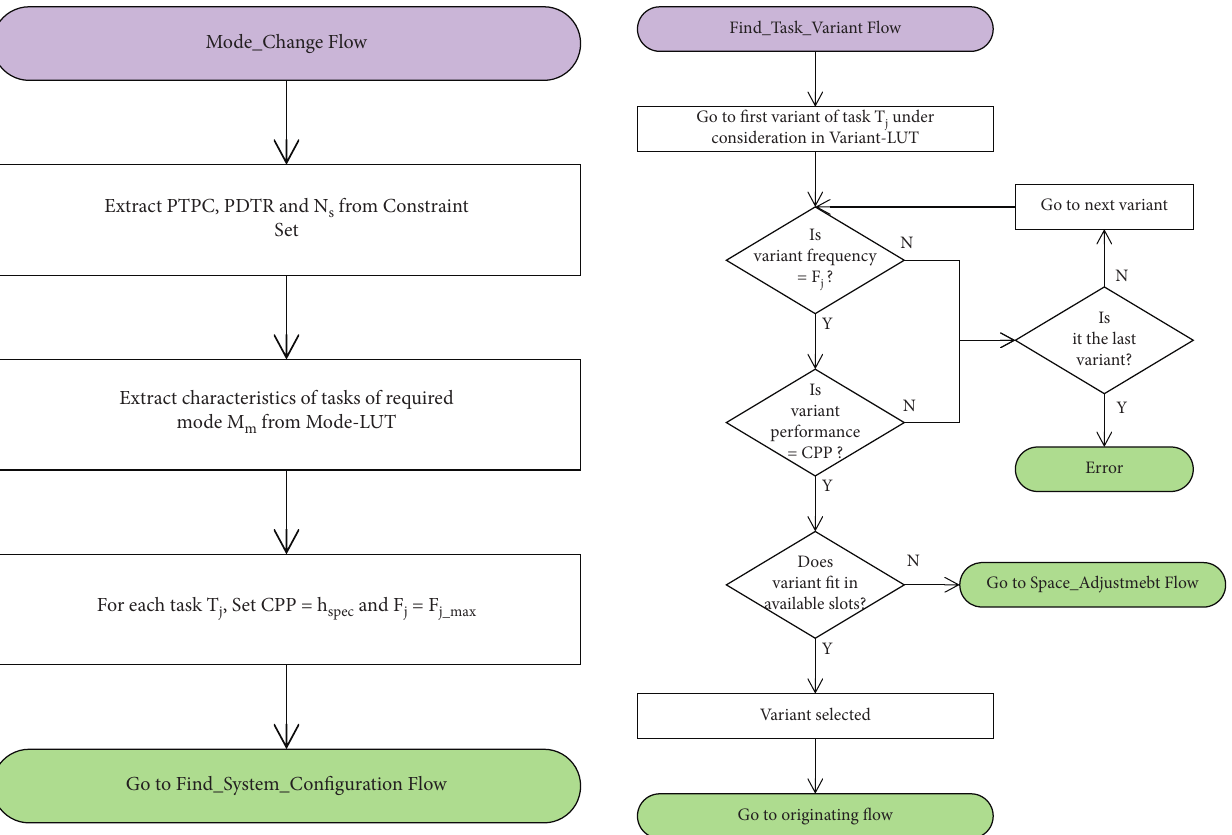
Figure 3: Mode_Change flow of Explorer.